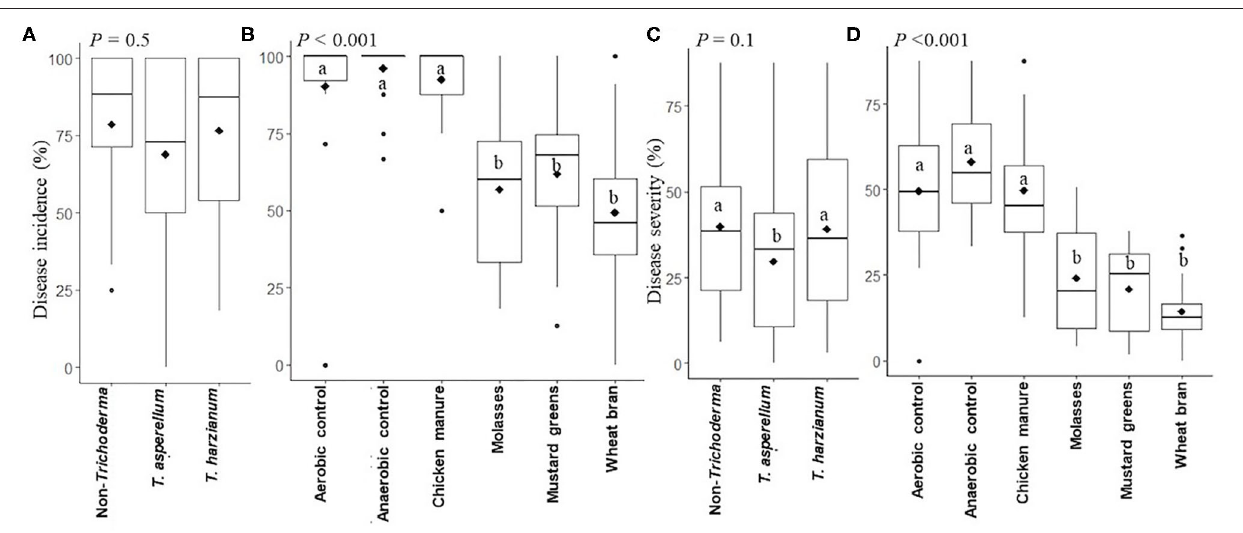
FIGURE 2 | Rhizoctonia root rot incidence (A,B) and severity (C,D) in radish affected by Trichoderma isolate inoculation (main plots) (A,C) and anaerobic soil disinfestation (ASD) carbon sources (subplots) (B,D) presented in box plots; black lines indicate median, black diamonds indicate mean values and black dots are outliers, P -value is the analysis of variance probability value after arcsine-square-root) transformation. Means followed by same letter(s) do not differ significantly at the indicated level of probability. Data presented are from two combined independent experiments each with three